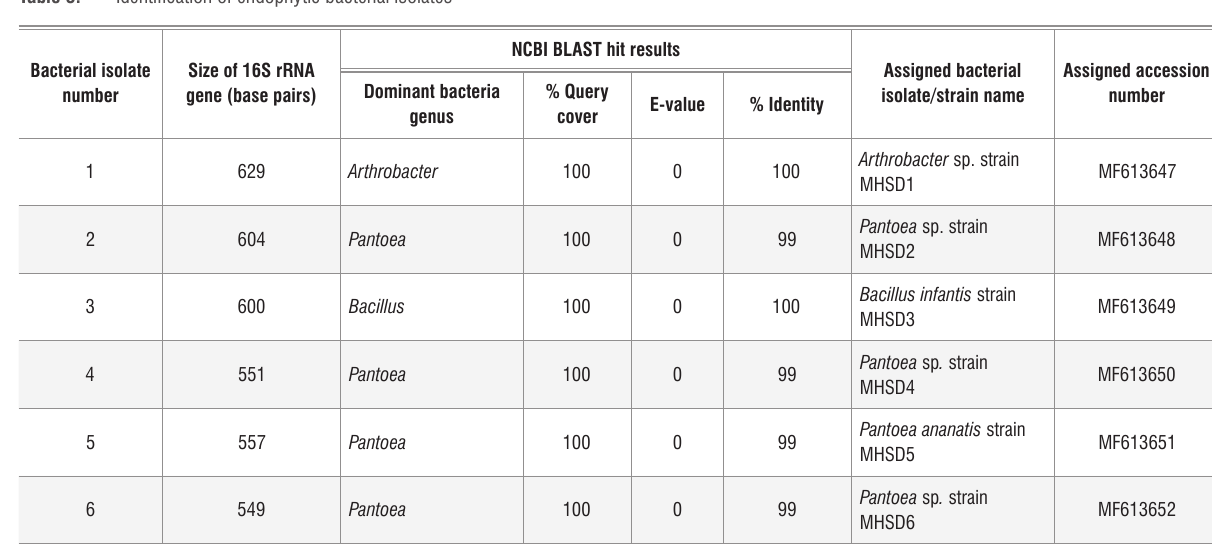
Identification of endophytic bacterial isolates